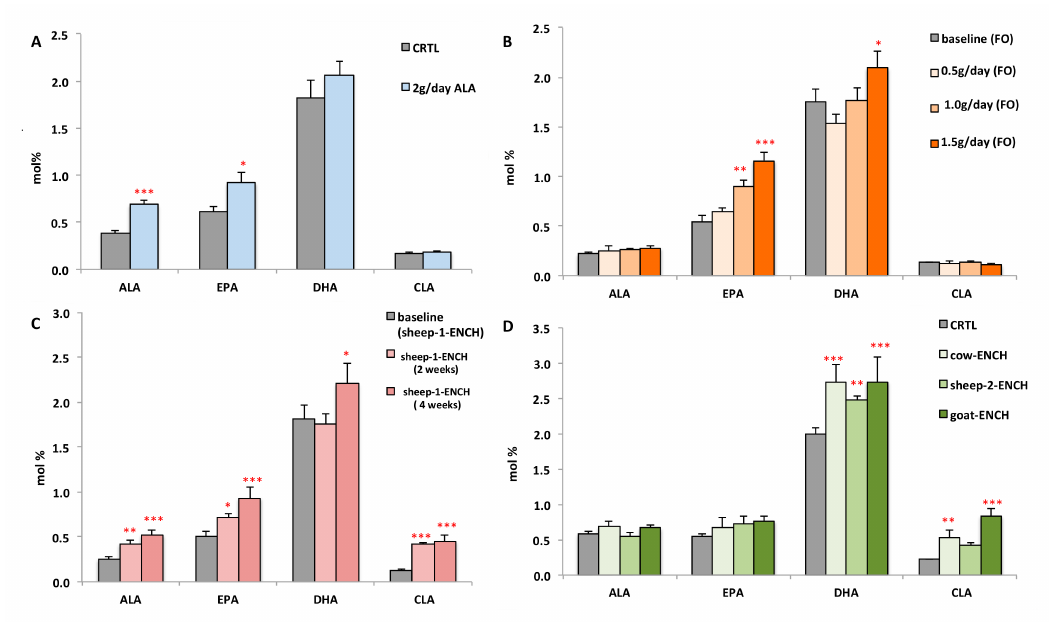
Figure 3. Levels of the main n-3 FA (ALA, EPA, and DHA) and CLA measured in the plasma of subjects consuming different diets: ( A ) CRTL diet (4 g/day olive oil) or 4 g/day linseed oil (~2 g of ALA) for two months, n = 12/group; ( B ) 0.5 g/day, 1.0 g/day, or 1.5 g/day of FO for two weeks, n = 15/group; ( C ) 90 g/day of sheep-1-ENCH cheese for two and four weeks, n = 15/group; ( D ) 50 g/day of different ENCH or CRTL cheeses for two months, n = 36/group. The data are expressed as mol % and represent mean ± SEM per group; * p < 0.05; ** p < 0.01; *** p < 0.001 versus baseline (time 0) or control group. Int. J. Mol. Sci. 2018 , 19 , x FOR PEER REVIEW